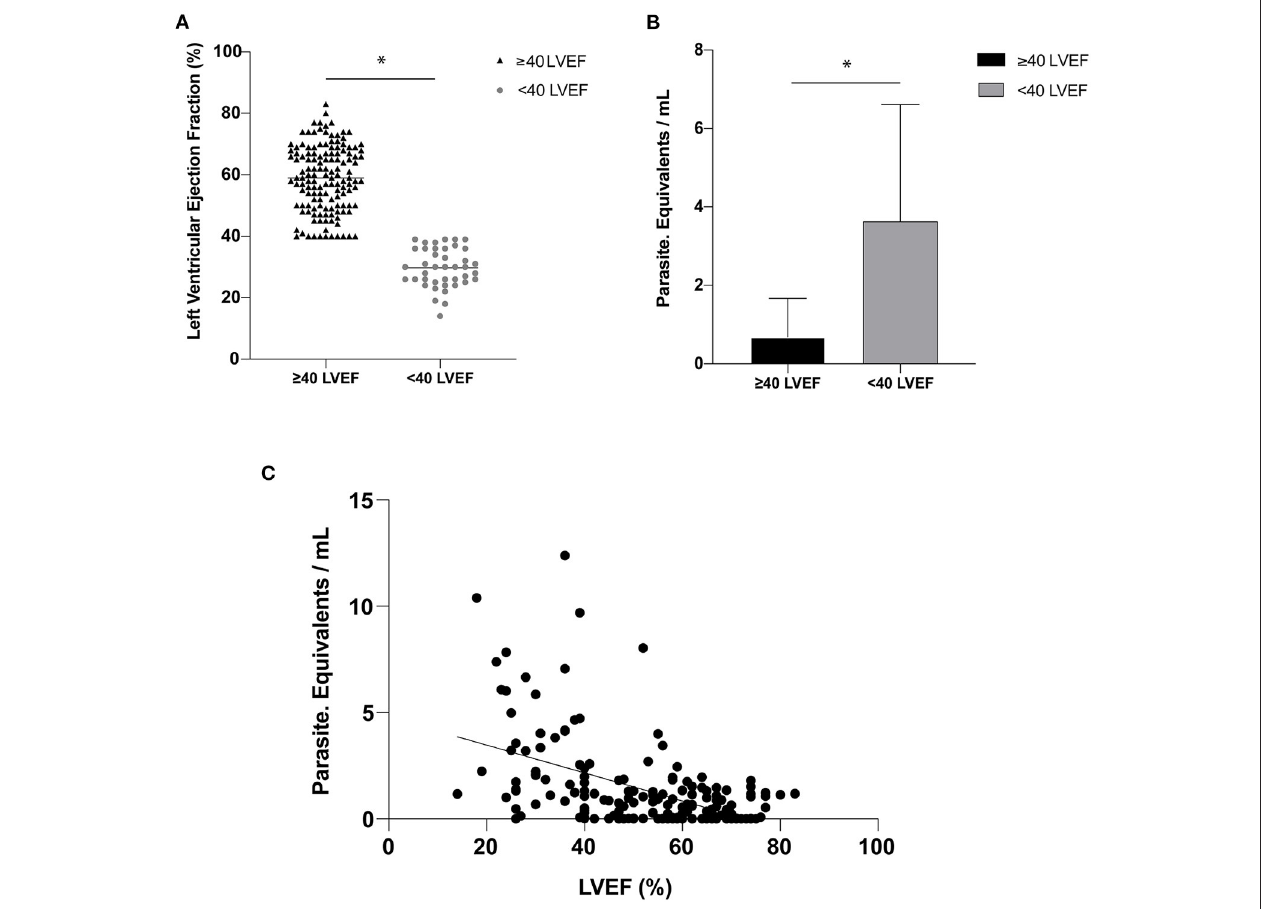
FIGURE 1 | (A) Left ventricular ejection fraction (LVEF) expressed as a percentage (%)—(horizontal line represented the mean of the LVEF values for each group). (B) Parasitic load expressed in parasite equivalents per milliliter of blood for Left ventricular categories below and equal or above 40%. (C) Correlation between parasitic load and LVEF ( r = 0.49; p < 0.0001). The symbol (*) indicates a significant difference between the groups with p < 0.05.